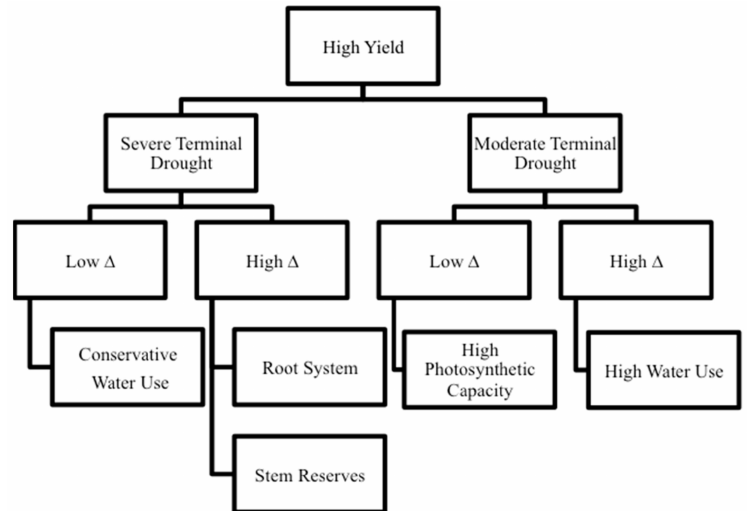
Figure 1. Flow chart of beneficial traits associated with low and high ∆ genotypes in distinct terminal drought environments. A severe terminal drought may favor low ∆ genotypes expressing conservative water use or high ∆ genotypes with the ability to develop deep roots or store carbohydrates pre-anthesis for later translocation to the grain. A moderate terminal drought may favor low ∆ genotypes with high photosynthetic capacity or high ∆ genotypes able to use all of the available soil